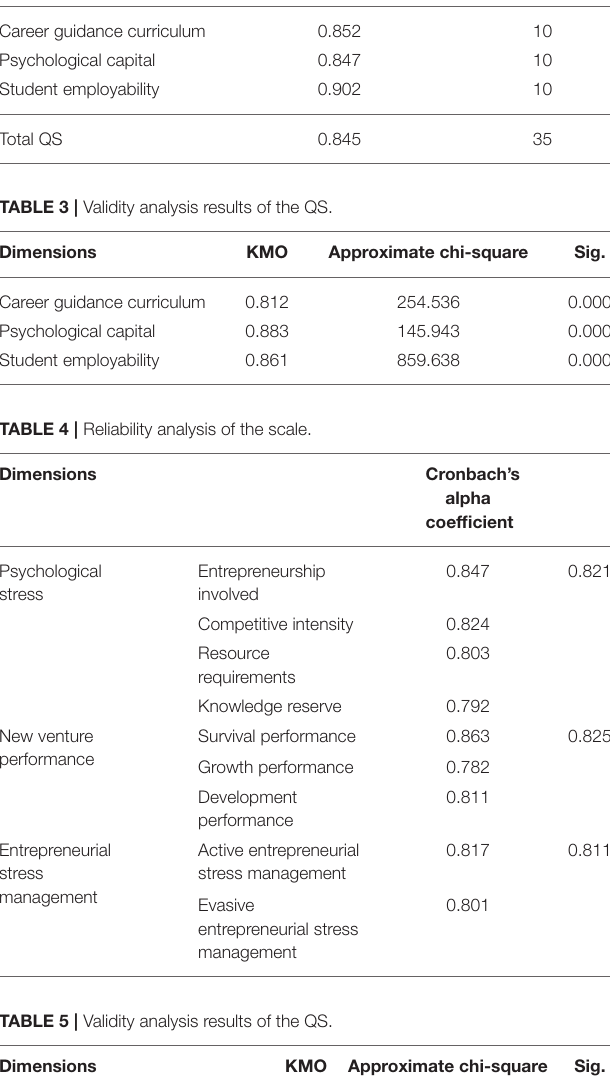
TABLE 6 | Single-factor ANOVA of each variable.